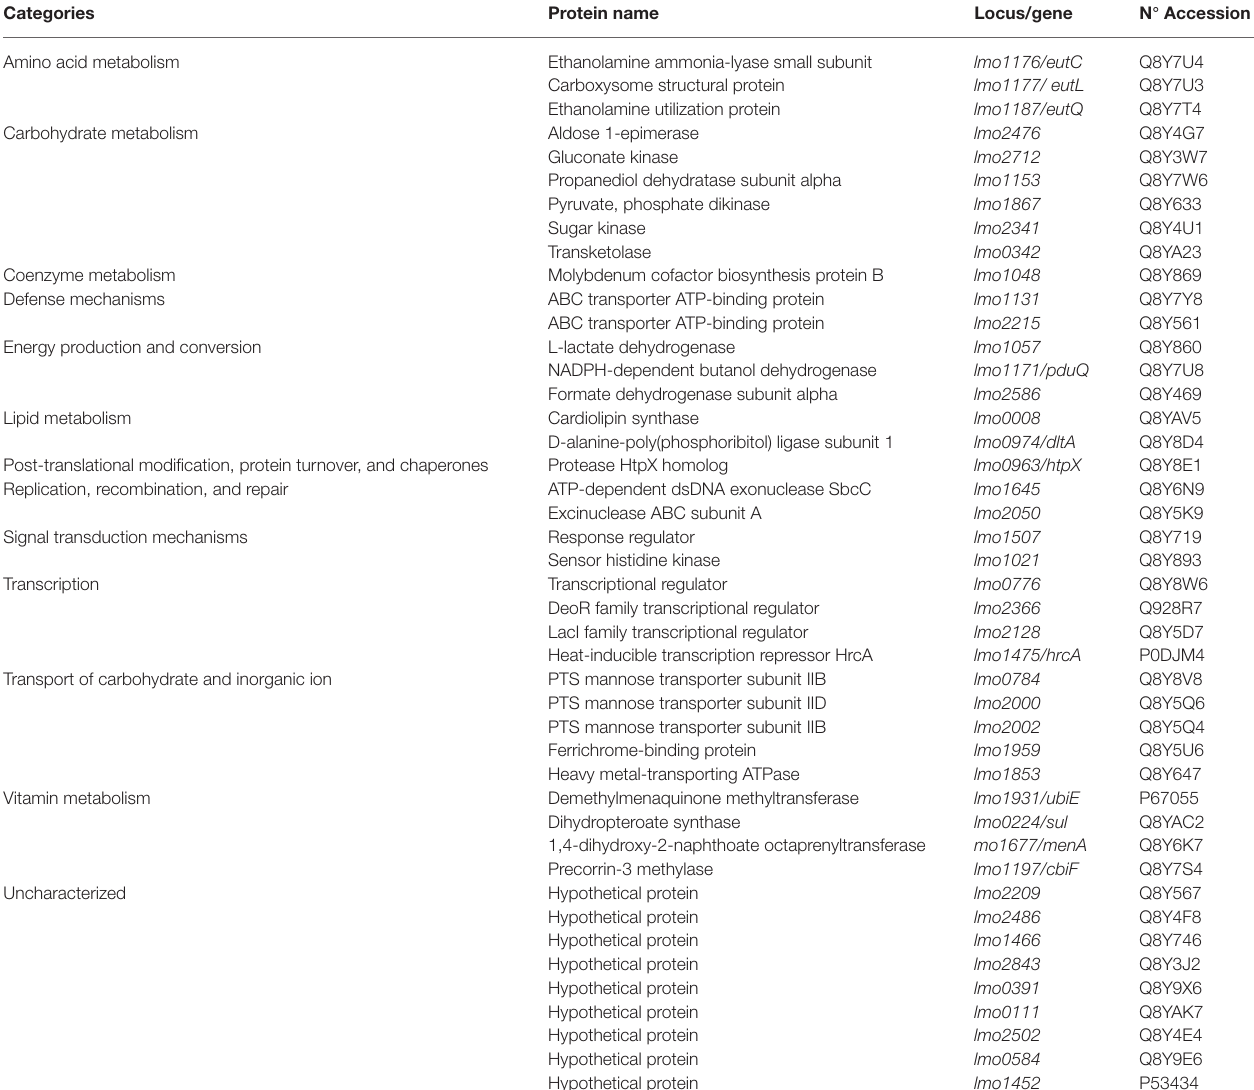
TABLE 1 | Proteins identified exclusively in biofilm cells treated with lactocin